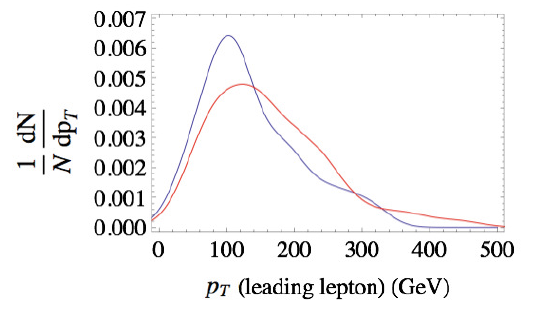
Figure 7 . Comparison of hardest lepton p T spectra (normalized) for two di(cid:11)erent mass spectra with mass splittings m ~